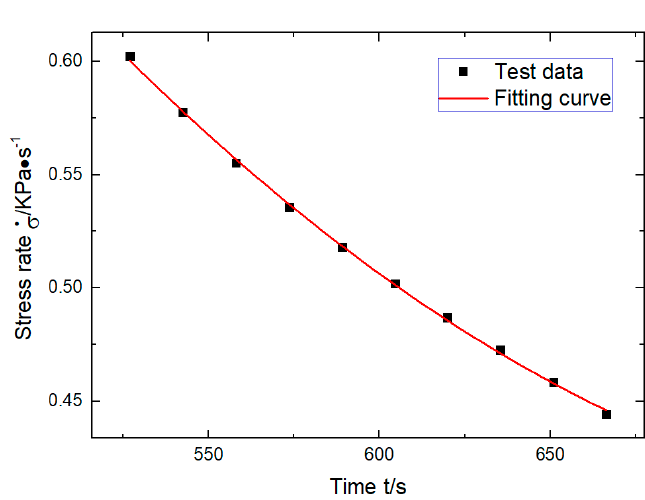
Figure 7. Obtaining zero-time stress rate by quadratic fitting epitaxy of stress rate.